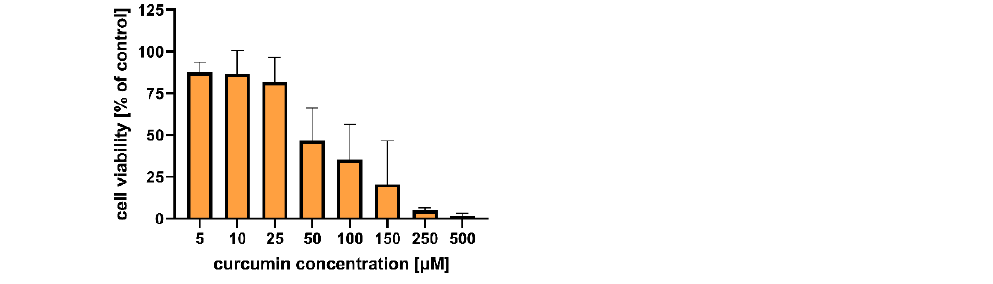
Figure 7. In vitro cytotoxicity of curcumin to human colon adenocarcinoma (LoVo) cells after 24 h of incubation. Cell viability was evaluated by an MTT assay. The results are presented as the means ± S.D.